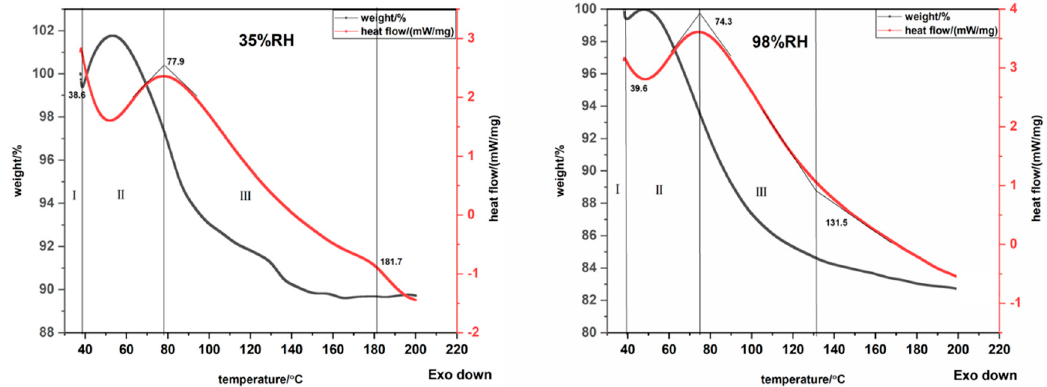
Figure 7. TGA-DSC analysis of absorbed water state on modified PAA at 20 °C, 35%RH and 20 °C, 98%RH.